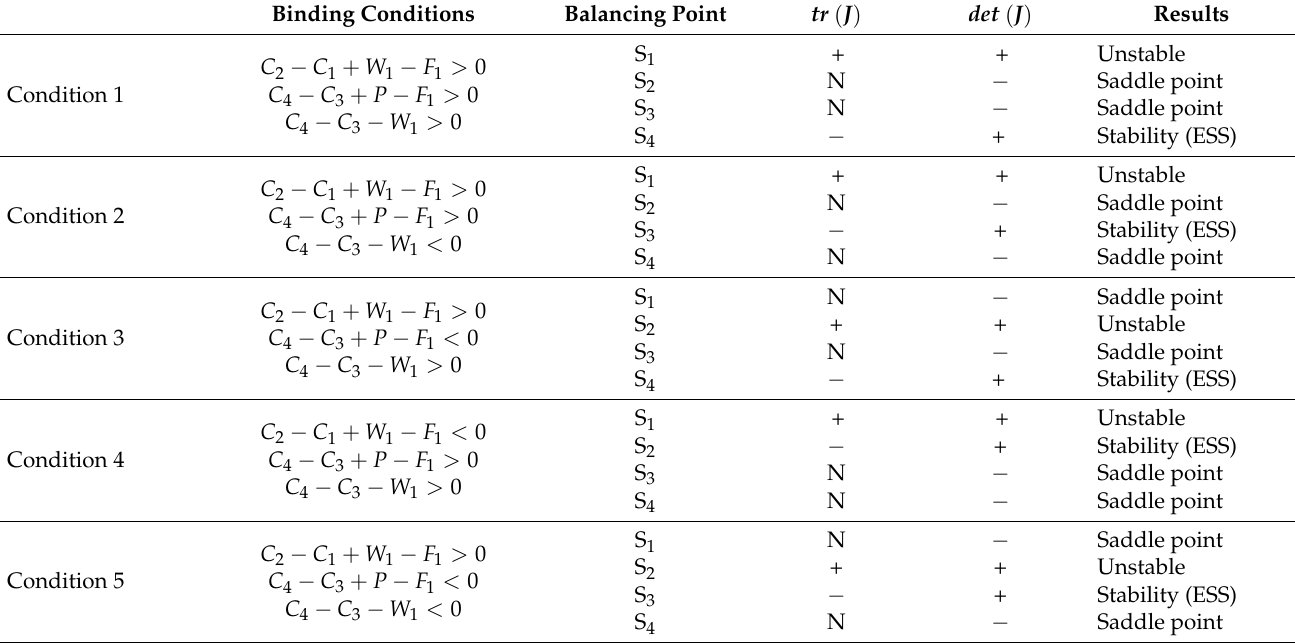
Table 5. Stability determination of the equilibrium point of the evolutionary game